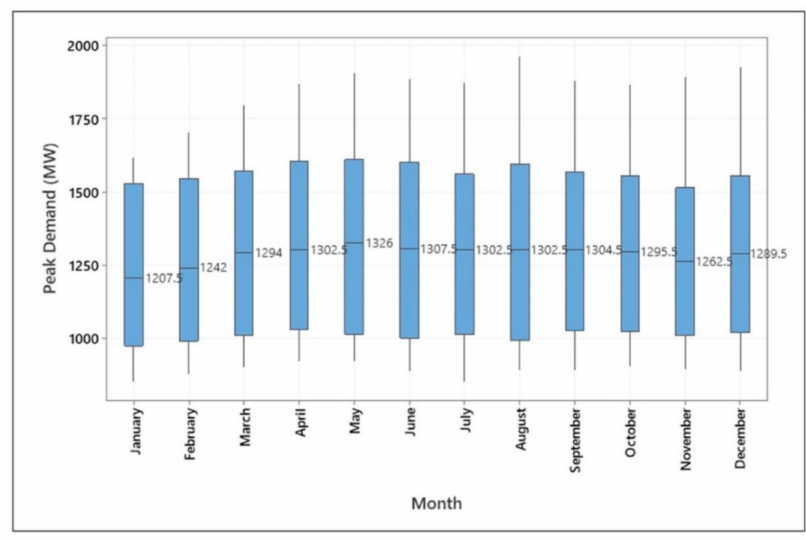
Figure 6. Monthly peak demand growth of Panama from 2004 to 2019.